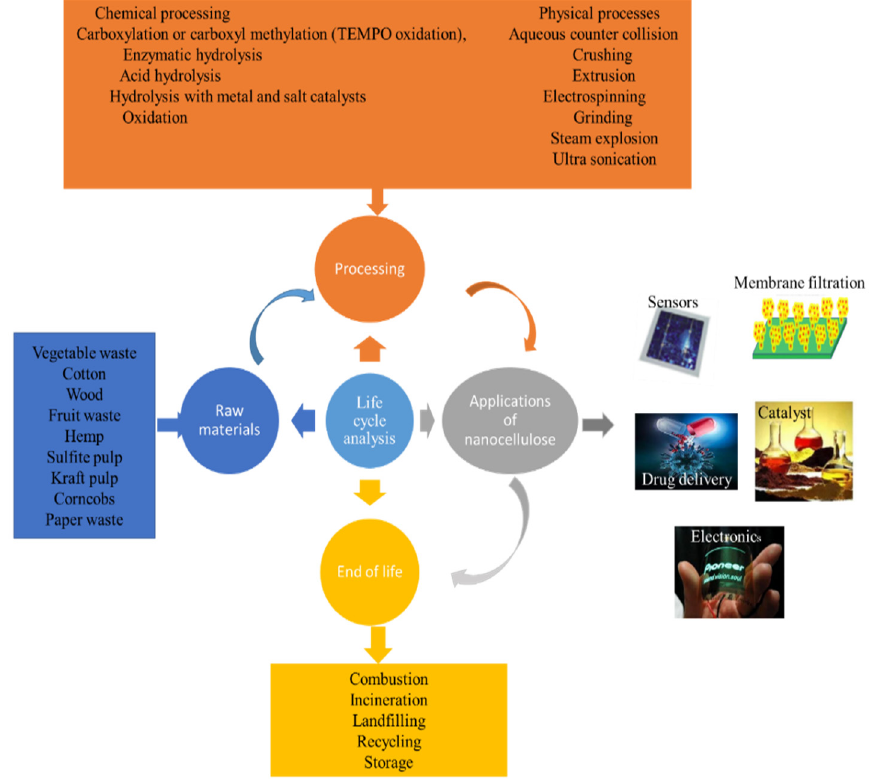
Figure 9. Life cycle analysis of nanocellulose from different waste materials, from the cradle to the grave (modified from Faroughi et al. [151]).